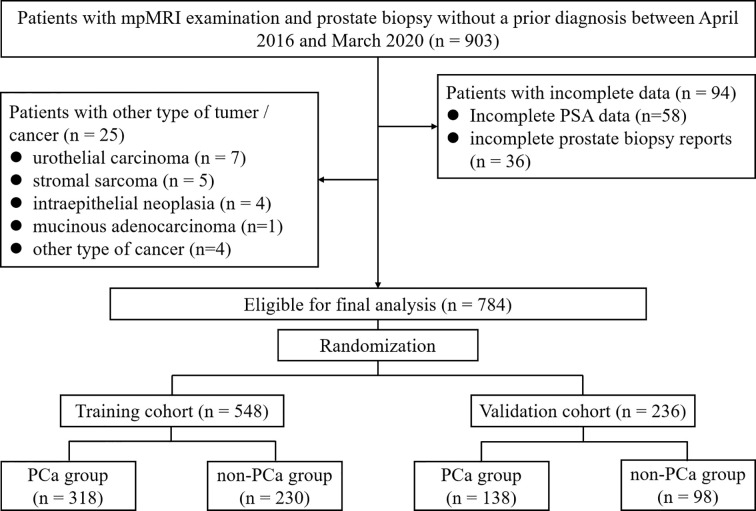
Flowchart of study participants selection.